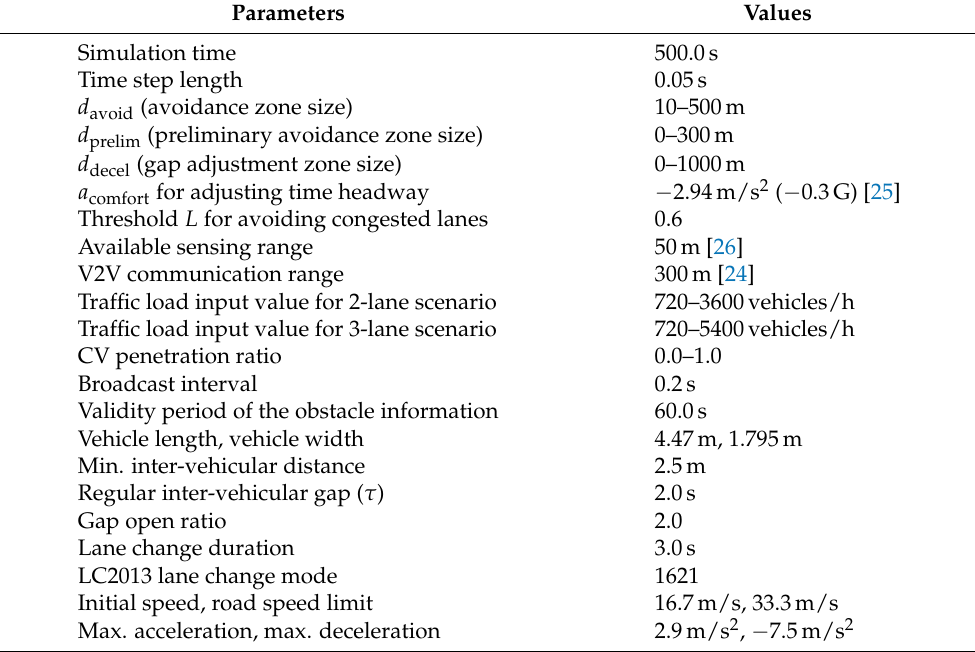
Table 3. Simulation